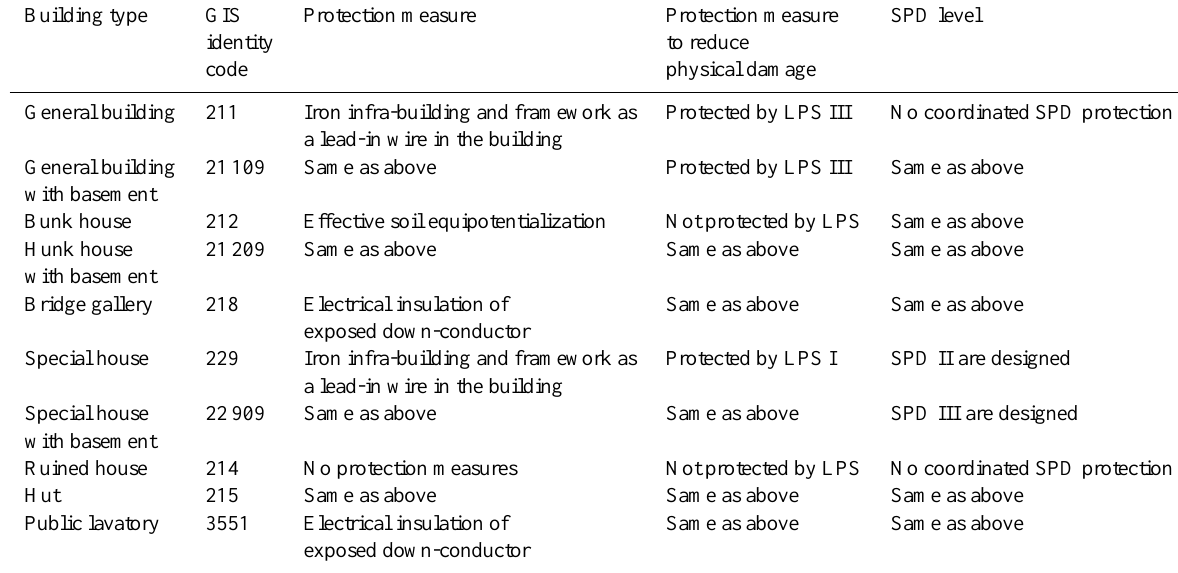
Table 1. The building types and associated lightning protection measures in Beijing. Building